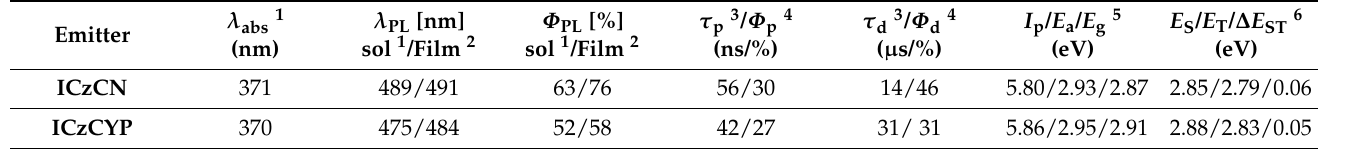
Table 1. Photophysical properties of ICzCN and ICzCYP